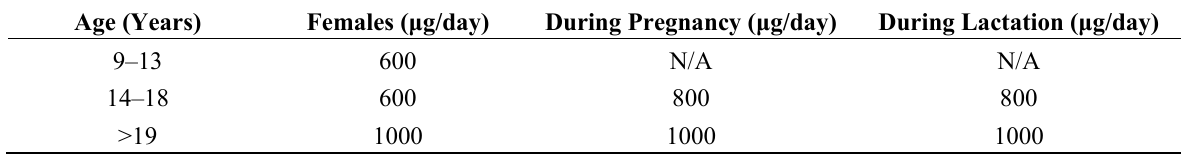
Table 2. Tolerable upper intake levels for folate in women